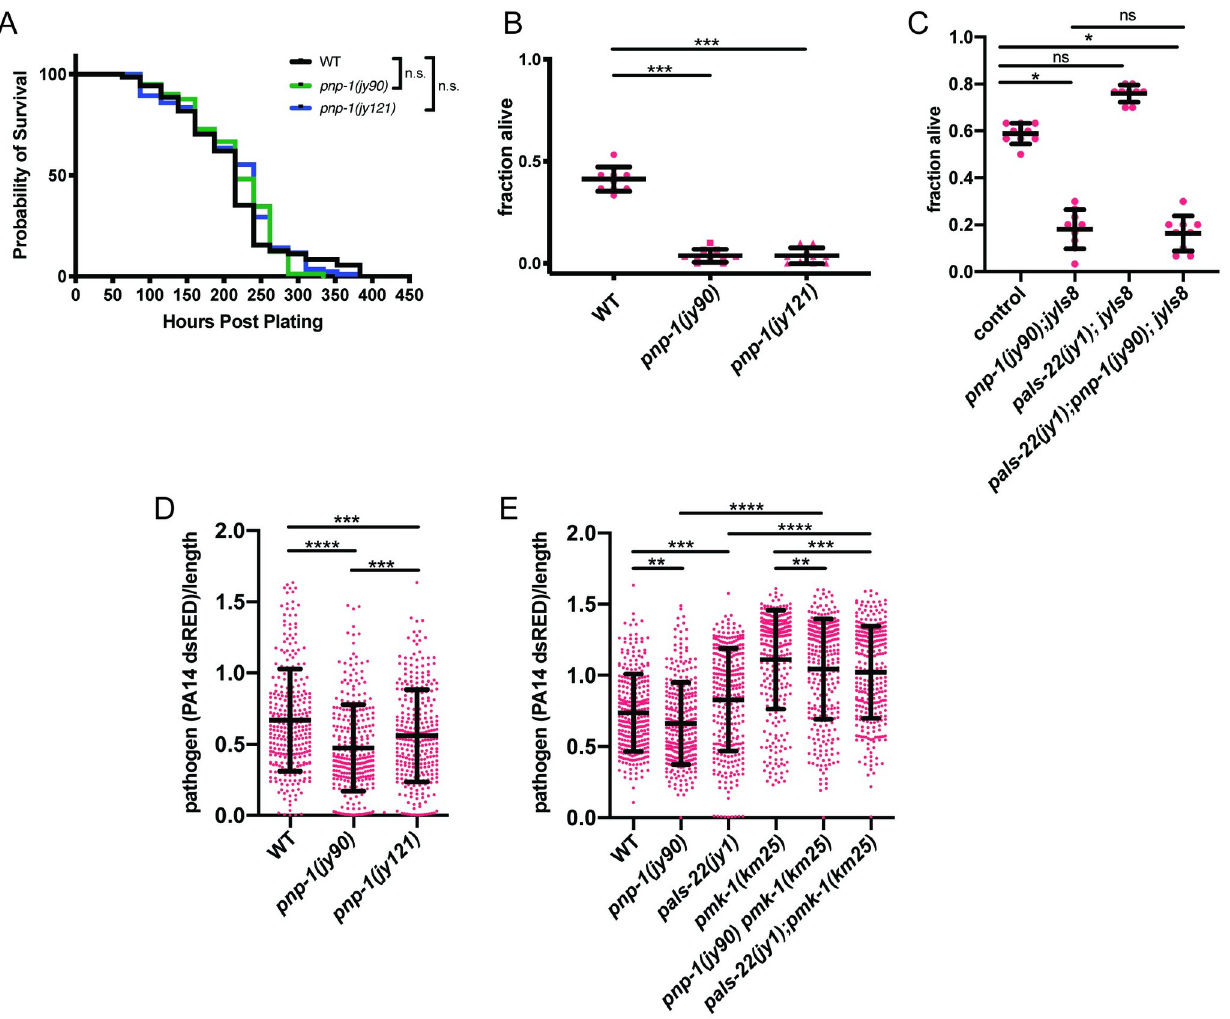
Fig 4. Lifespan, thermotolerance and P . aeruginosa resistance phenotypes of pnp-1 mutants. A) Lifespan of wild-type animals, pnp-1(jy90) and pnp-1 (jy121) mutants. n = 90 animals per genotype. Results from one representative experiment of four independent experiments is shown (see S6 Fig for additional three experiments). Survival of each mutant population was compared to that of the wild-type population with the Log-rank (Mantel-Cox) test. B) Survival of wild-type animals, pnp-1(jy90) and pnp-1(jy121) mutants 24 hours after 2 hours 37˚C heat shock. C) Survival of wild-type animals, pnp-1 (jy90) , pals-22(jy1) and pals-22(jy1); pnp-1(jy90) mutants 24 hours after a 2 hour 37˚C heat shock. B, C) For one experiment, three plates per genotype with 30 worms per plate were tested. One dot represents the survival from one plate. The graphs show the mean survival of three independent experiments. Error bars are SD. D) Quantification of PA14-dsRED pathogen load in L4 stage wild-type animals, pnp-1(jy90) and pnp-1(jy121) mutants at 16 hpi. E) Quantification of PA14-dsRED pathogen load in L4 stage wild-type animals, pnp-1(jy90) , pals-22(jy1) , pmk-1(km25) , pnp-1(jy90) pmk-1(km25) and pals-22 (jy1); pmk-1(km25) mutants at 16 hpi. D, E) PA14-dsRED red fluorescence per animal was quantified with the COPAS Biosort machine and normalized to time-of-flight as proxy for the length of the animal. n = 300 animals per genotype. Graph shows the combined results of three independent experiments. Each dot represents an individual animal. Mean is shown with error bars as SD. B-E) ���� indicates p < 0.0001 by the Kruskal-Wallis test.